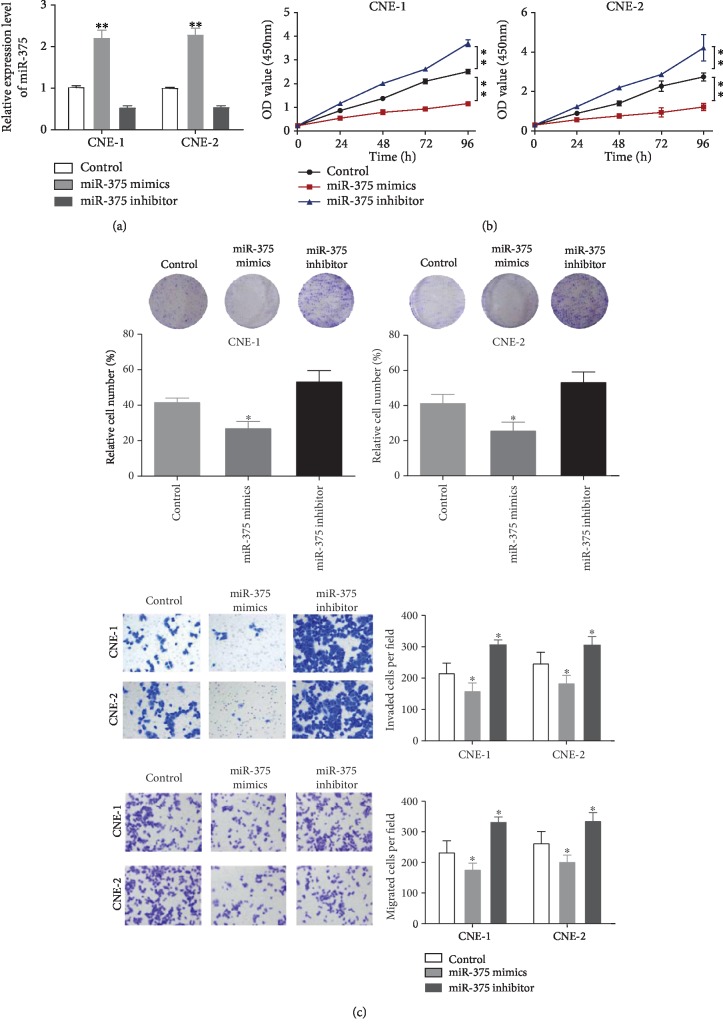
The progression of NPC cells was suppressed by the upregulation of miR-375. (a) The expression of miR-375 in transfected CNE-1 and CNE-2 cells was evaluated by qRT-PCR. (b) The MTT assay was performed to determine the viability of transfecting CNE-1 and CNE-2 cells with a miR-375 mimic or inhibitor. (c) Measured colony formation in cells that had already been transfected with miR-375 mimic or suppressor. Cell behavior was evaluated by transwell assay in cells that had completed the transfection process.